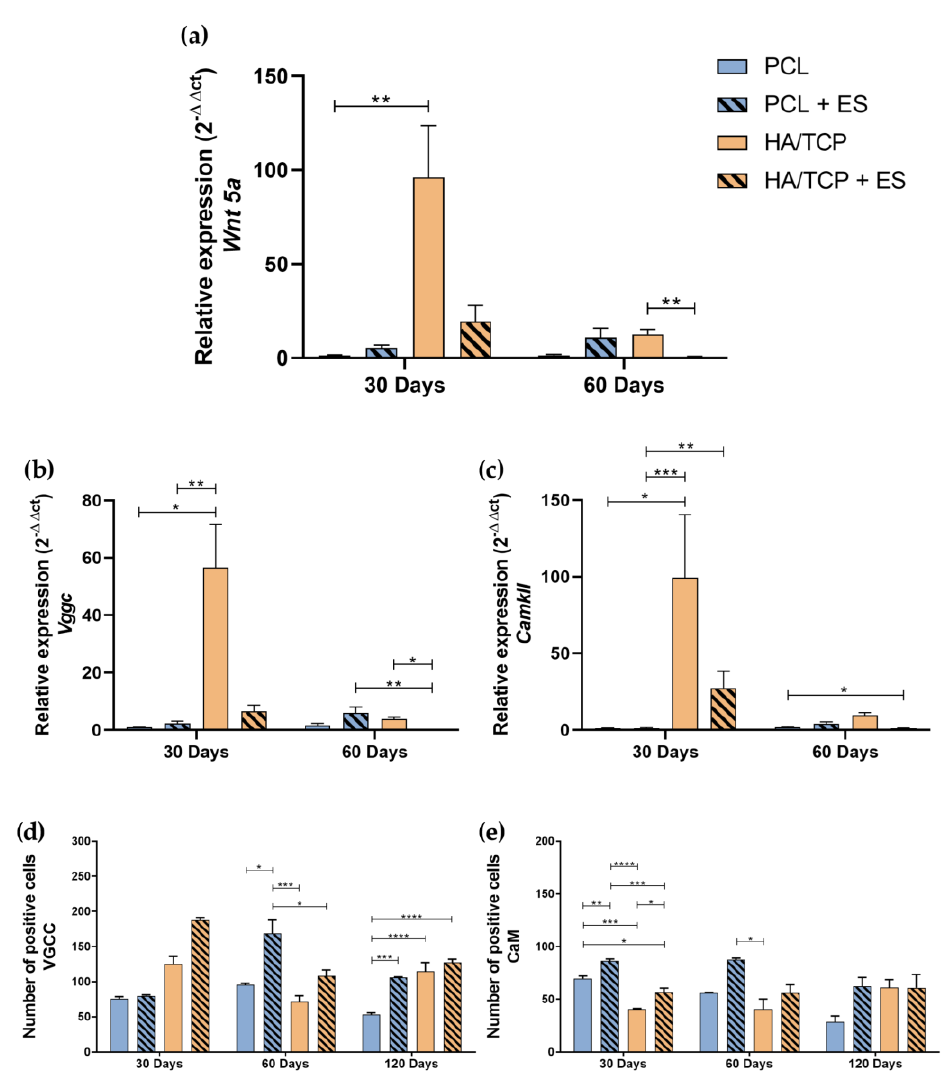
Figure 3. Relative gene expression of ( a ) Wnt 5a , ( b ) Vgcc and ( c ) CamkII (2 − ∆∆ ct ). Evaluation of the Ca 2+ /CaM signaling pathway by immunohistochemistry in 4 × 10 4 µ m 2 area of images: ( d ) Quantification of anti-VGCC positive cells; ( e ) Quantification of anti-CaM positive cells. Results were expressed as mean ± standard error of the mean (significance levels were established in * p < 0.05, ** p < 0.01, *** p < 0.001, **** p < 0.005).